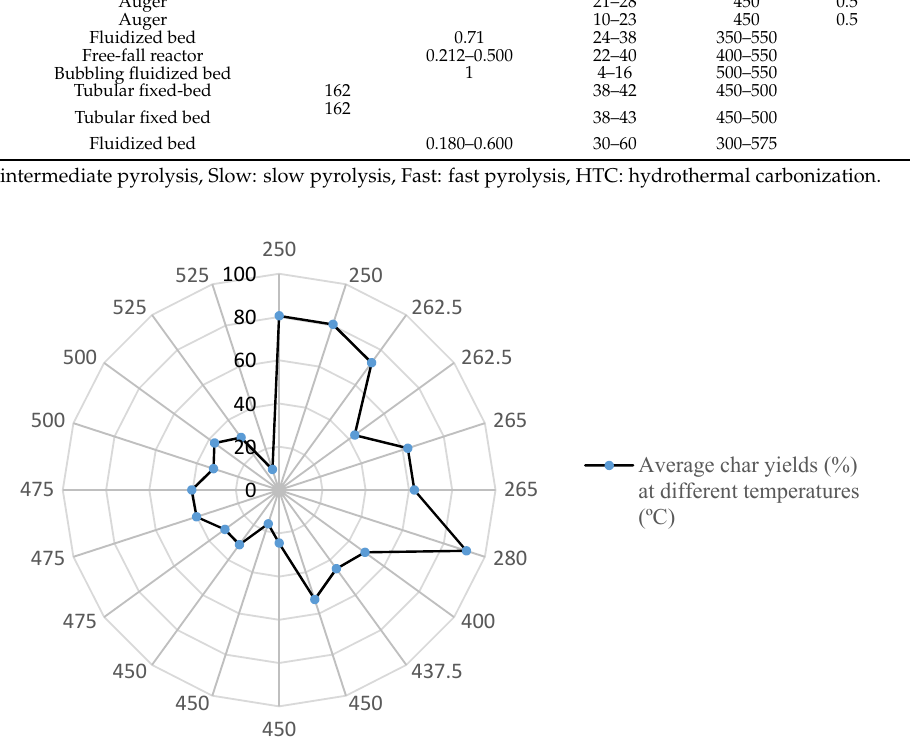
Figure 4. Temperature dependence of the char yields of the barks.